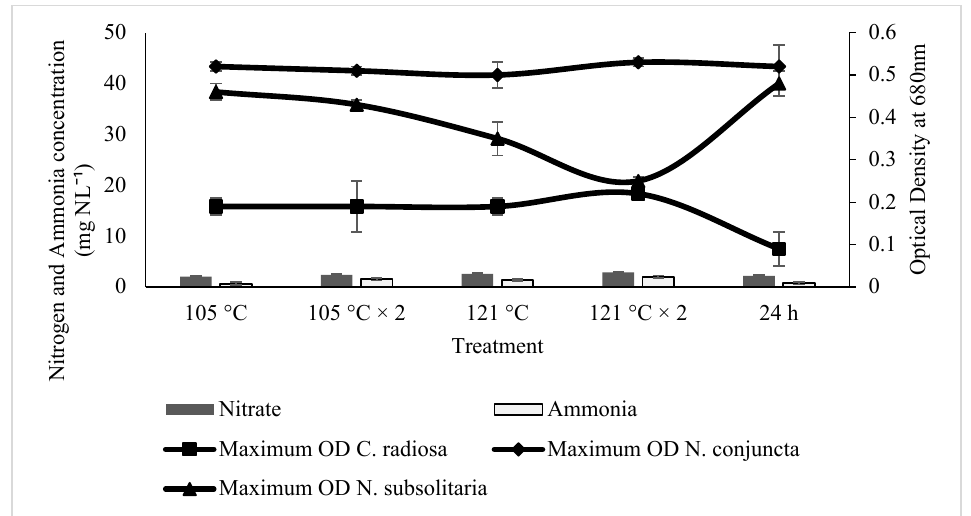
Figure 2. Effect of ammonia and nitrate concentration on the growth of C. radiosa, N. conjuncta , and N. subsolitaria from Ayer Hitam Forest Reserve (AHFR) with different extraction methods. The error bars ( n = 3) represent the standard deviation.